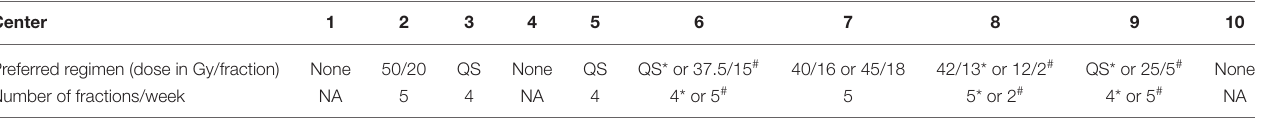
TABLE 3 | Dose-fractionation schedules for palliative radiotherapy. Center 1 Preferred regimen (dose in